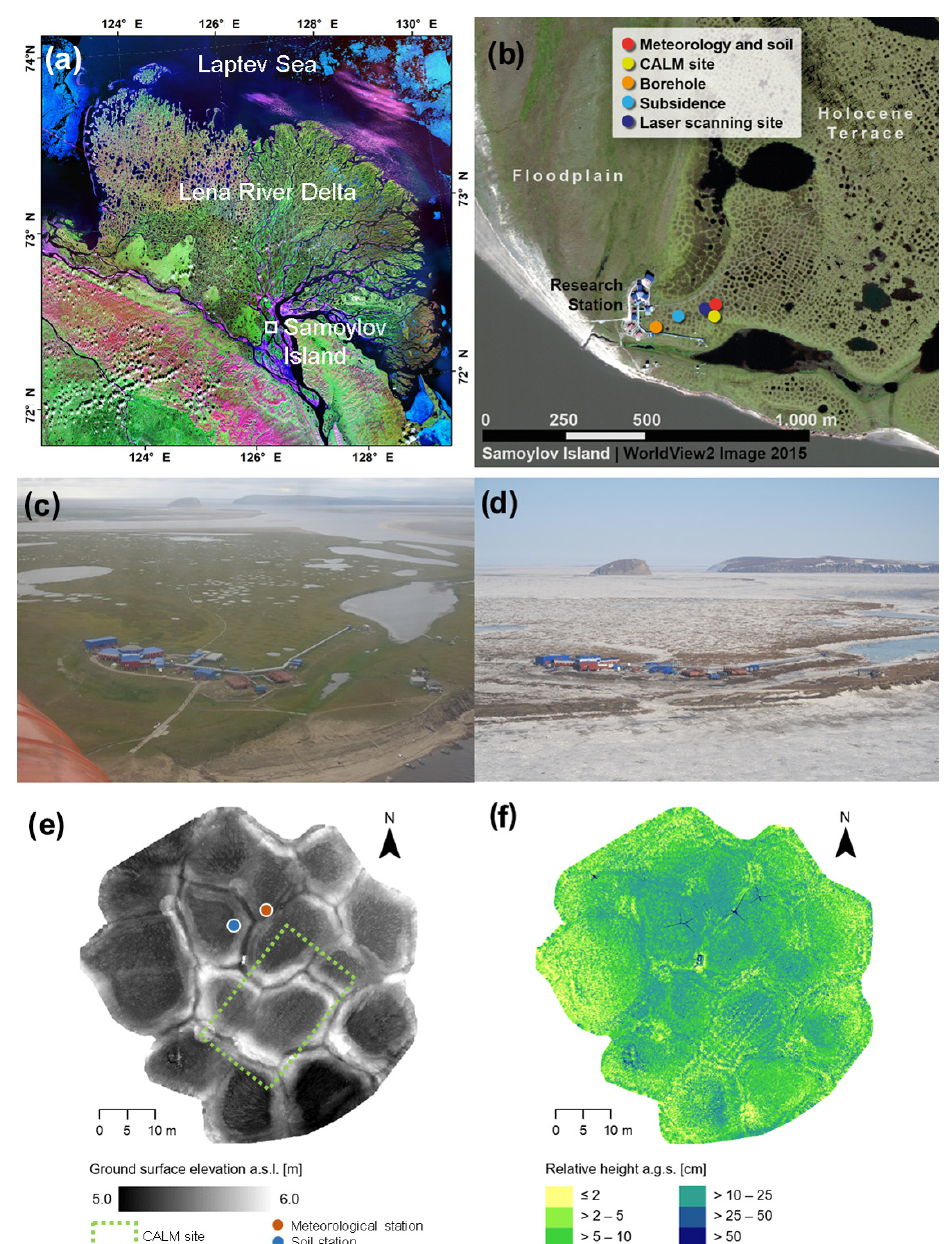
Figure 1. Samoylov research site. (a) Location of Samoylov Island in the Lena River delta, northeastern Siberia (Landsat-7 ETM+ Geo- Cover 2000). (b) Location of instrumentation and measurement sites. (c) The research site under summer conditions (September 2017) and (d) spring conditions (April 2014; photo by Torsten Sachs). (e) Digital terrain model obtained by terrestrial laser scanning (TLS) in Septem- ber 2017, and (f) relative heights of vegetation derived from TLS data acquired in September 2017. Further details of the methods of TLS data processing are provided in Appendix